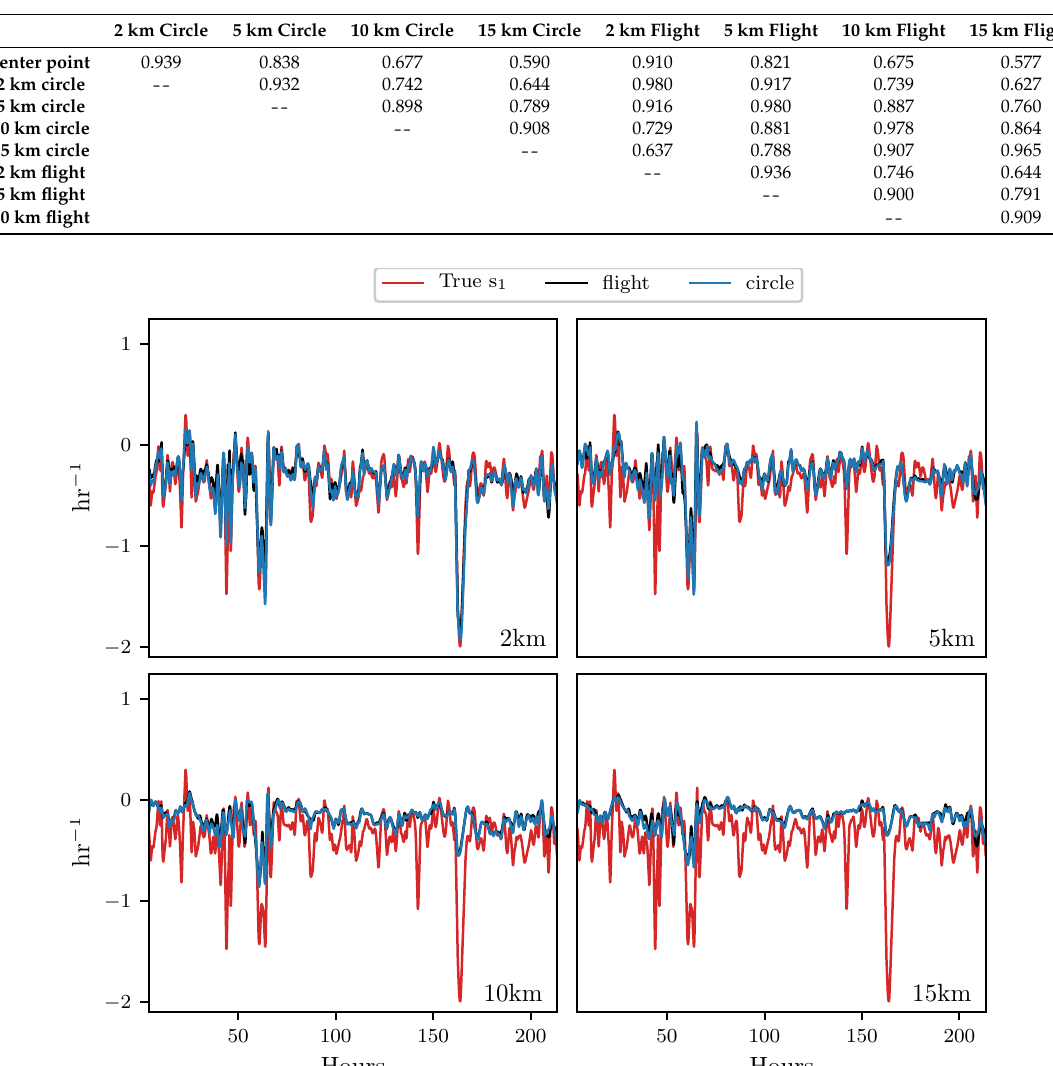
Table 2. Pearson correlation coefficients for attraction rate, s 1 , measurements. Coefficients range from 0.577 to 0.939.